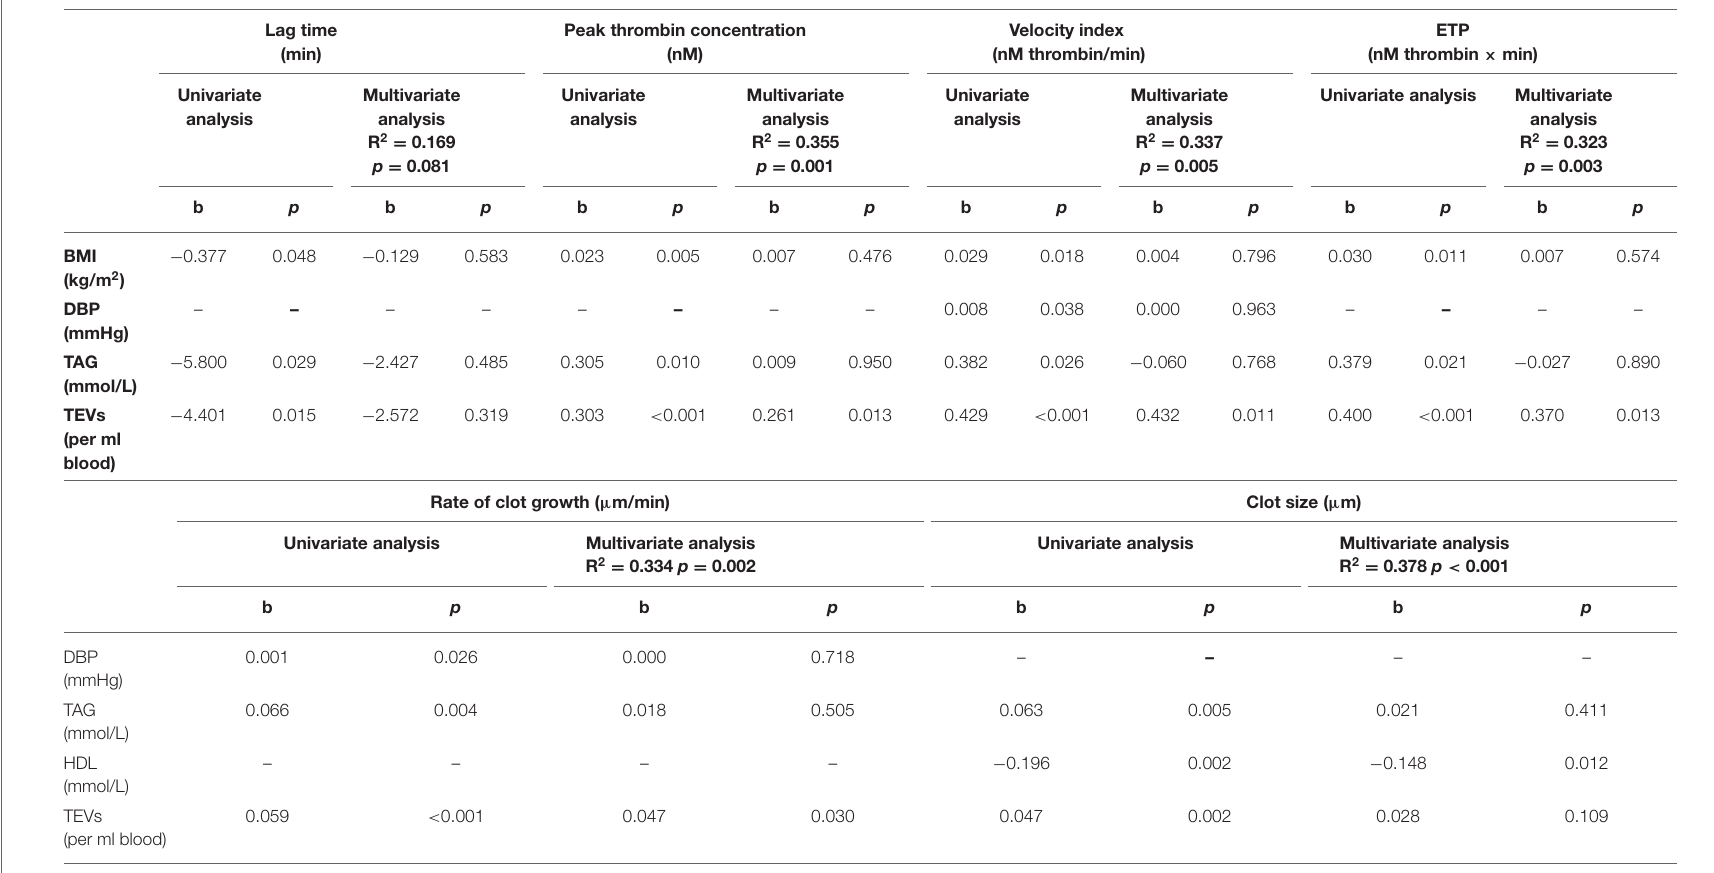
TABLE 4 | Association of thrombogenic risk markers with EV numbers and conventional risk